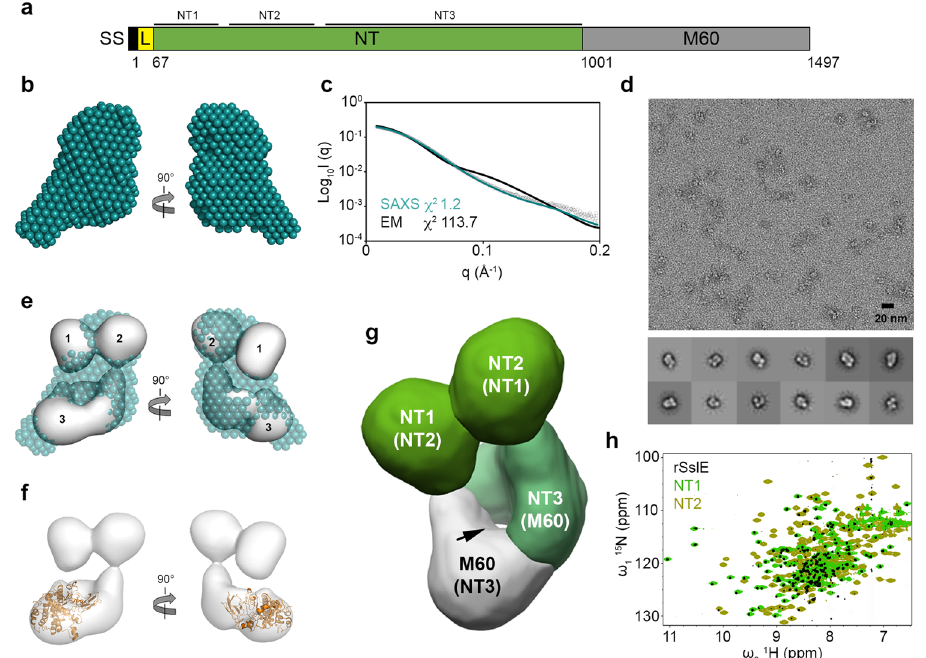
Fig. 1 Structural features of monomeric SslE. a Schematic of SslE from E. coli W with mature sequence numbers and structural features annotated. SS: periplasmic signal sequence; L: fl exible linker; NT: unique N-terminal region; M60: peptidase/mucinase domain. b SAXS bead model of rSslE at pH 7.4. c Fit of the SAXS bead model (teal line) and negative-stain TEM map (black line) of rSslE to the rSslE SAXS data (black open circles) with χ 2 of 1.2 and 113.7, respectively. d Representative negative-stain TEM micrograph of rSslE (pH 7.4) at ×50,000 nominal magni fi cation with representative 2D classi fi cations. Scale bar represents 20 nm. e Overlay of the 22 Å resolution TEM map (grey) and SAXS bead model (teal) with the three de fi ned regions in SslE highlighted. f Docking of an SslE M60 domain homology model (orange) into the TEM map. g TEM map of rSslE coloured based on domain organisation. Possible alternative assignments of the NT1 and NT2 domains in regions 1 and 2, and the NT3 and M60 domains in region 3 are shown in parentheses. The NT3-M60 interdomain channel is highlighted with an arrow. h TROSY 1 H 15 N-HSQC spectrum of rSslE (black) overlaid with 1 H 15 N-HSQC spectra of the SslE NT1 (light green) and NT2 (olive green)